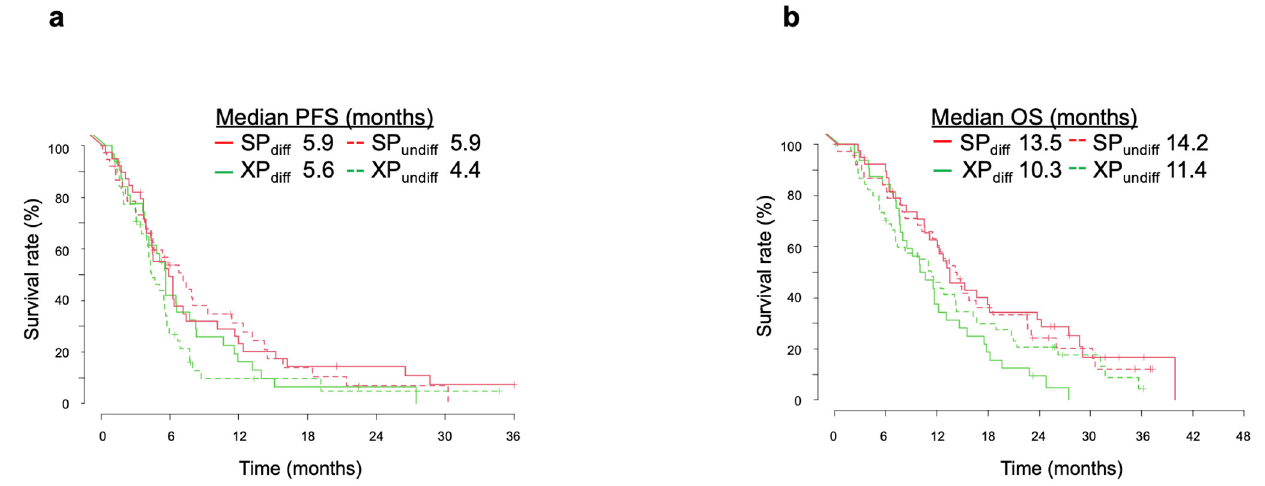
Figure 3. Kaplan–Meier analysis of PFS ( a ), and OS ( b ) according to differentiated (diff, solid lines) or undifferentiated (undiff, dotted lines) tumor types in the SP and XP arms of the integrated anal- ysis.